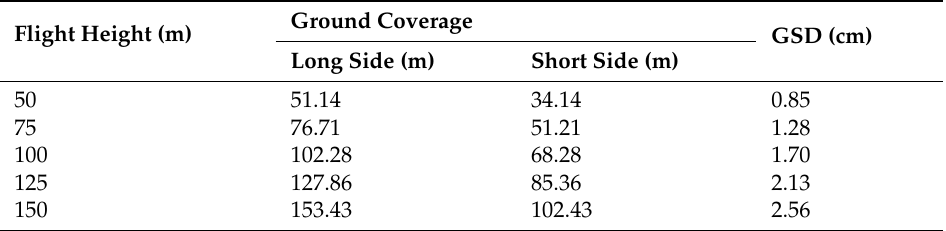
Table 1. Ground coverage and GSD (Ground Sample Distance) under different flight